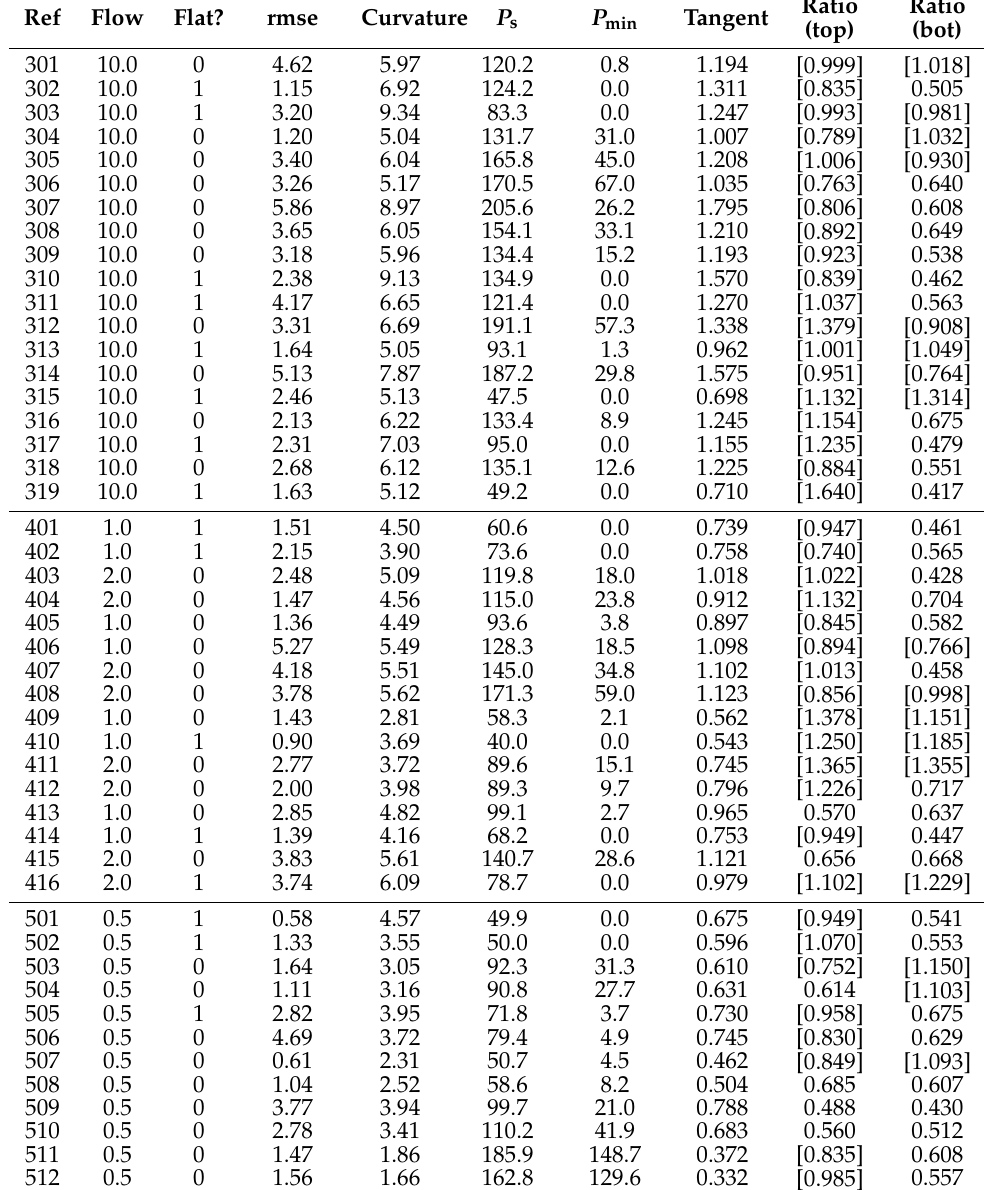
Table A1. Summary table for 47 pO 2 pressure profiles. ‘Ref’ = vnn where v = [3, 4, 5] identifies dataset, nn = profile index; ‘Flow’ = aCSF flow rate [mL/min]; ‘Flat’ = flag indicating paracosh (1) or parabolic (0) fit; ‘rmse’ = rms error for curve fit [mmHg]; ‘Curvature’ = 10 3 × ( 2 a ) [mmHg/ µ m 2 ]; P s = fitted surface pressure at x = L boundary [mmHg]; P min = fitted pressure at x = 0